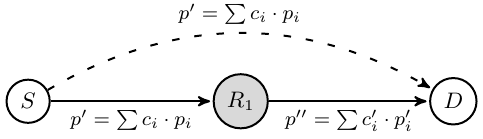
Figure 2: Intra-flow NC cannonical